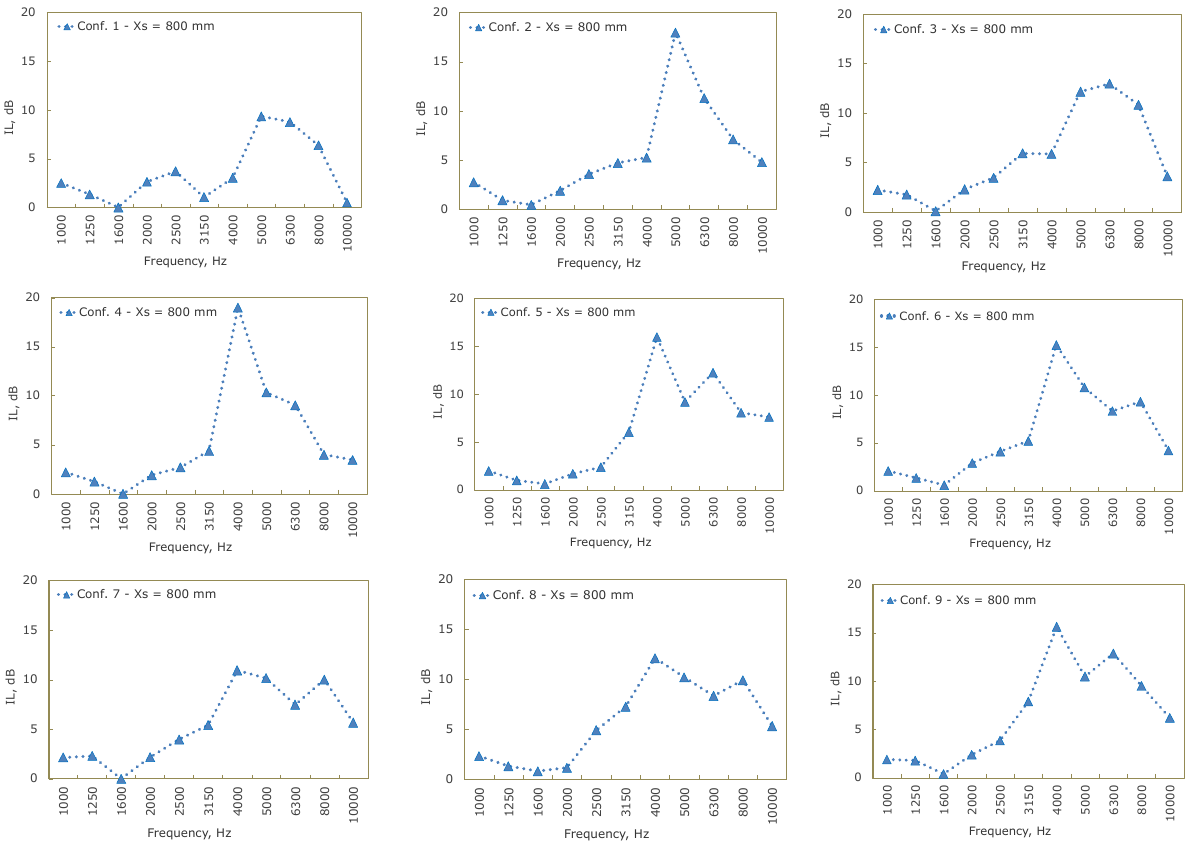
Figure 6. Insertional Loss (IL) results related to the first set of measurements. Distance between source and edge of barrier ( Xs ) equal to 800 mm. Distance between receiver and edge of barrier ( Xr ) equal to 800 mm.